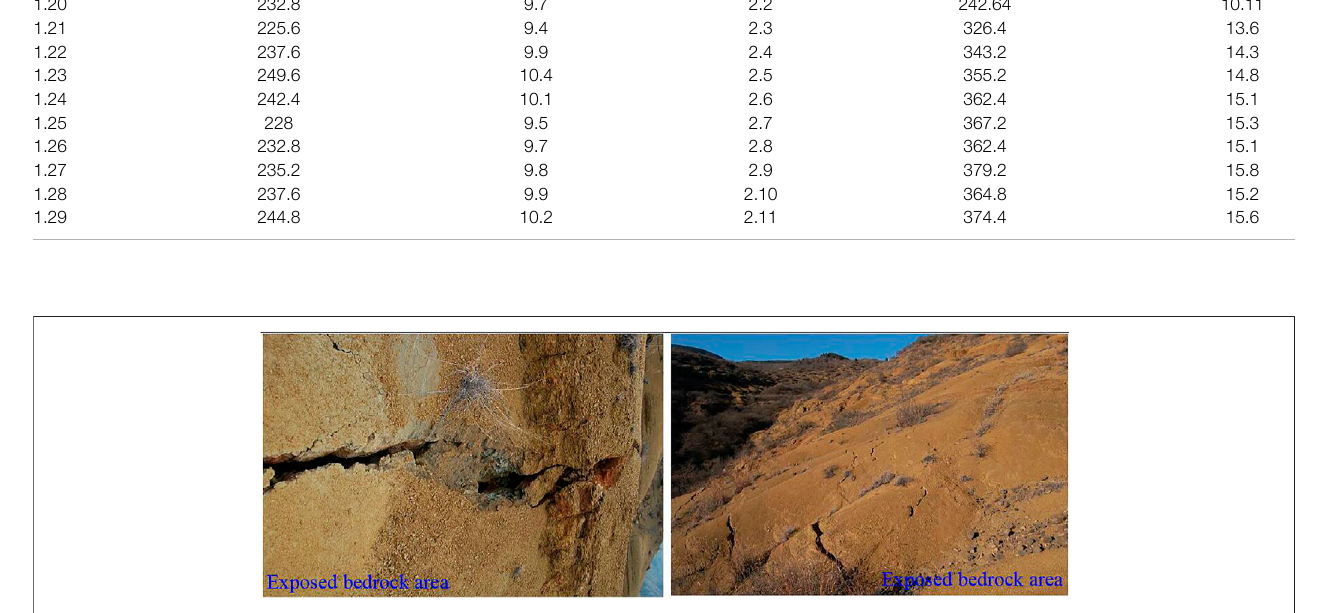
FIGURE 5 | Surface rock cracks above the working face.